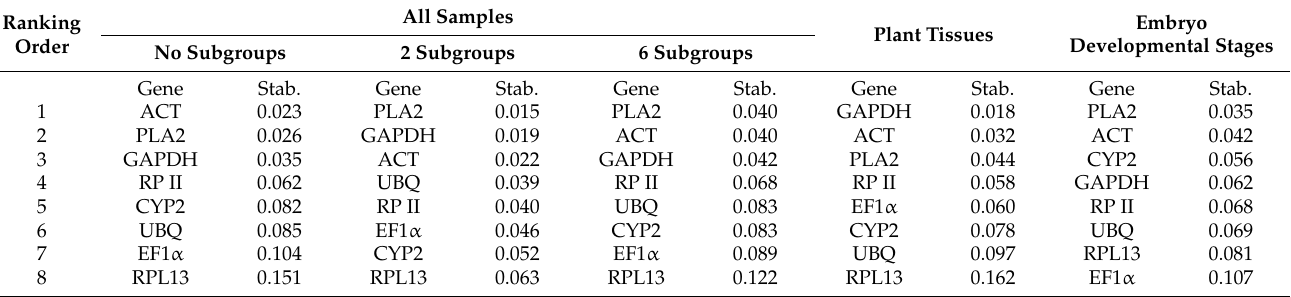
Table 3. Ranking of candidate reference genes in order of their expression stability as calculated by